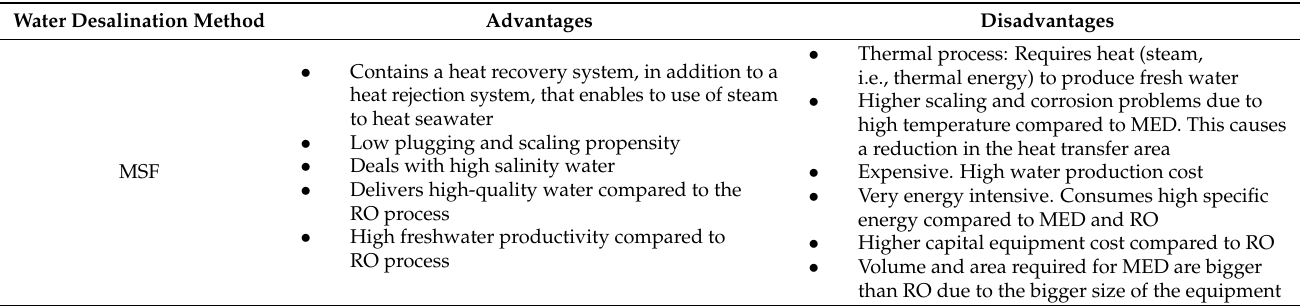
Table 1. Advantages and disadvantages of selected water desalination methods [25–27].